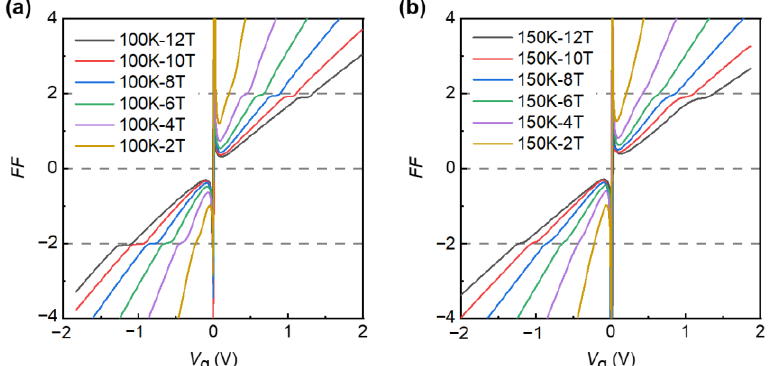
Figure 4. ( a ) Filling factor of R xy as a function of graphite-gate voltage at T = 100 K in different mag- netic field (from B = 2 T to 12 T). The horizontal gray lines indicate the hall plateau values of h /±2 e 2 . ( b ) Same as ( a ), but measured at T = 150 K.